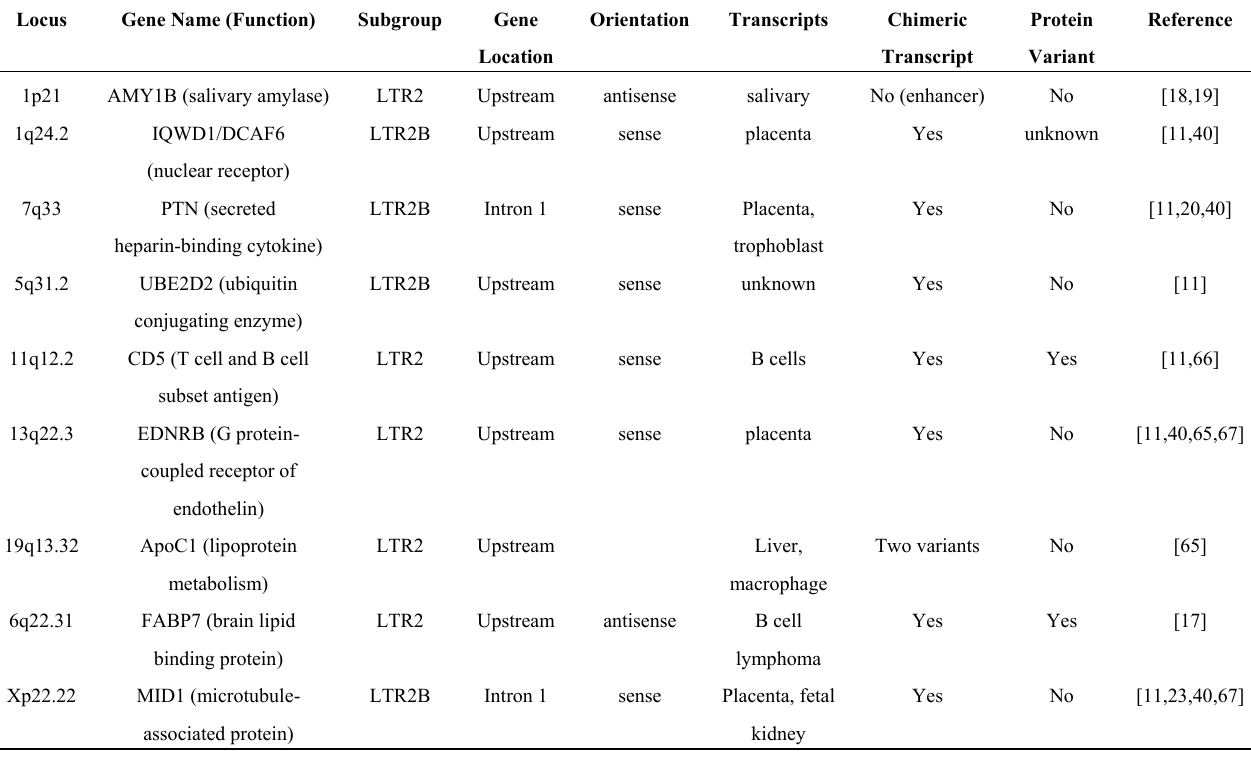
Table 2. HERV-E integration influences human